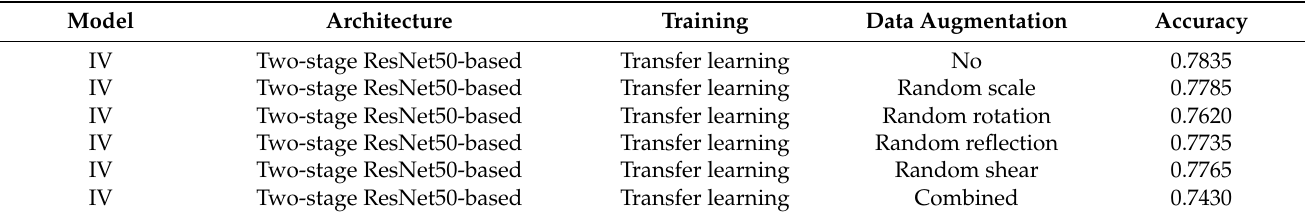
Table 2. Comparison of types of augmentation techniques.